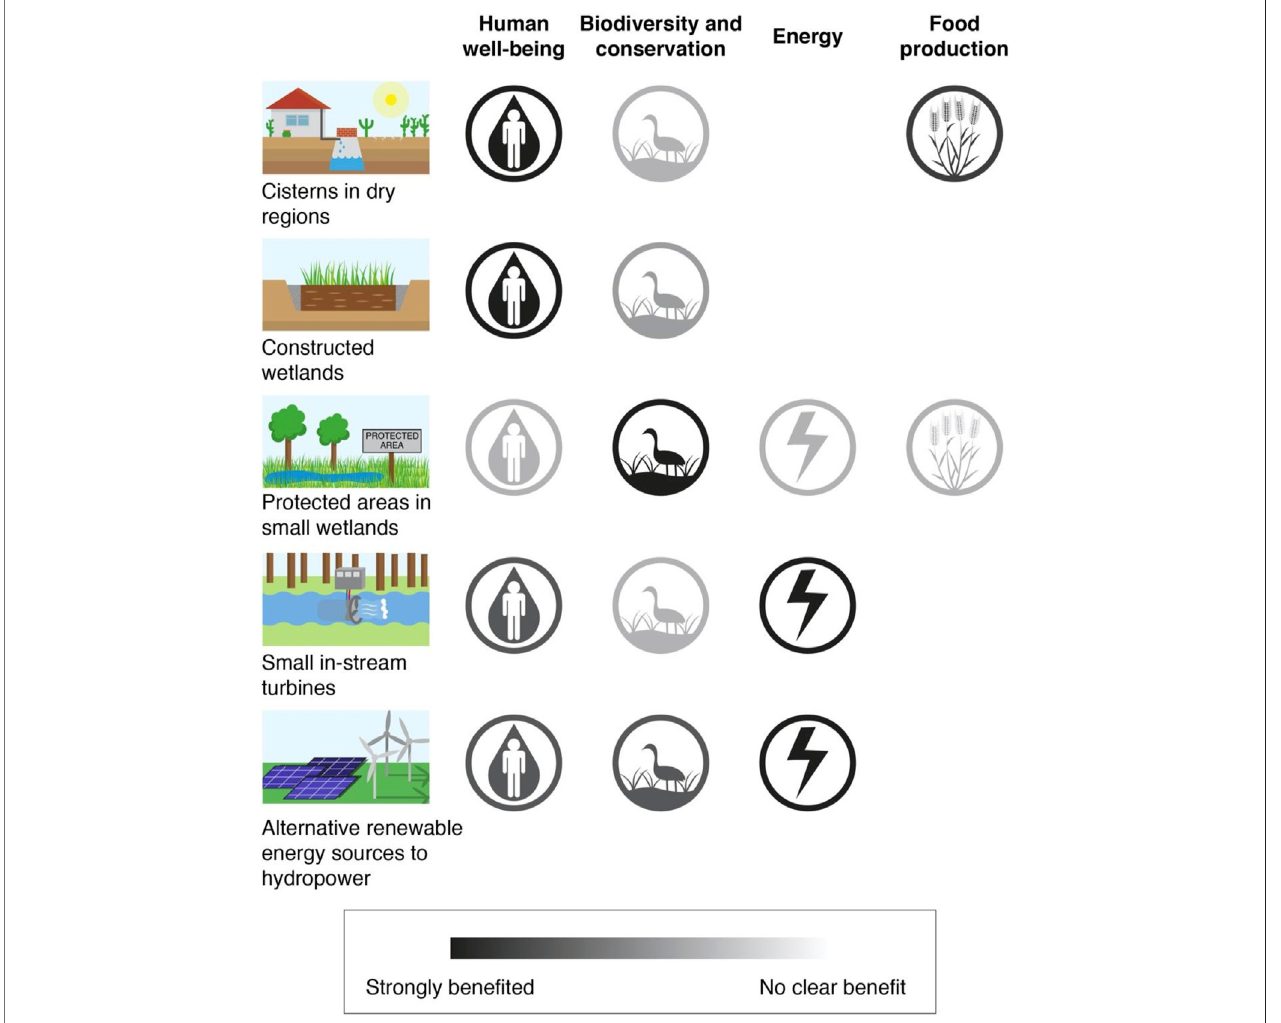
FIGURE2| Multisectoral solutions to the management and conservation of water resources based on the logic of the nexus water-food-energy-ecosystem. Cisternsofferareliablesourceofwaterforhumanconsumptionandfoodproduction andfavortheconservation oftemporary aquaticenvironmentsindryregions. Constructed wetlands are an alternative solution for basic sanitation in small cities, with positive impacts on biodiversity. The establishment of new protection areas in small wetlands favors biodiversity, in addition to ensuring water for the production of food and energy. Small instream turbines are a low-cost solution for power generation in small riverside communities, which improves the local livelihoods, without impacting biodiversity. The expansion of alternative sources of renewable energy to hydropower has positive socio-environmental results, without altering the energy production for economic